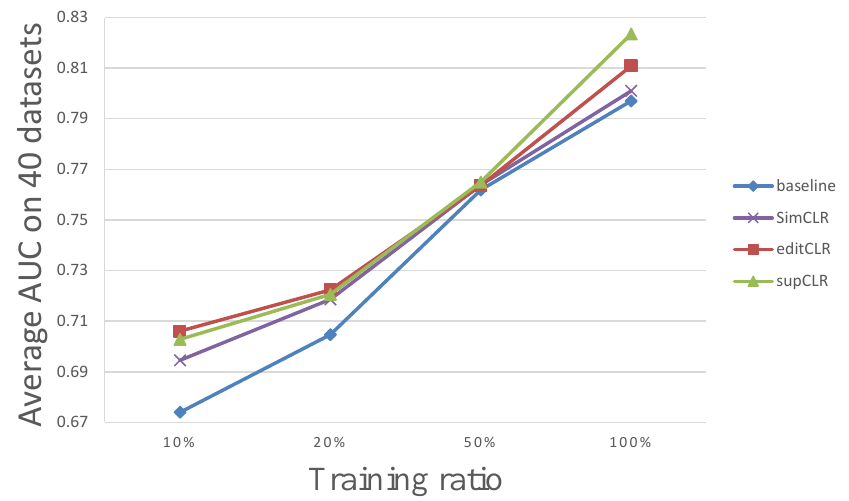
Figure 7. The distribution of AUC results on all datasets with different training